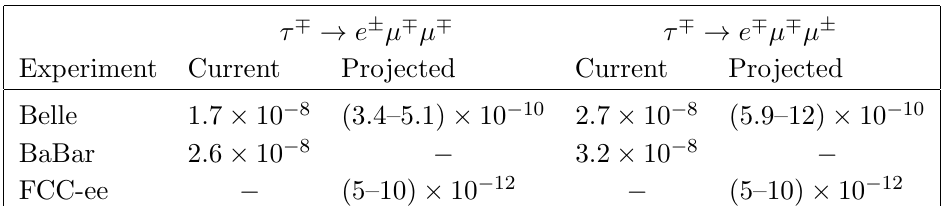
Table 2. Current and projected 90% C.L. limits on the (cid:28) branching